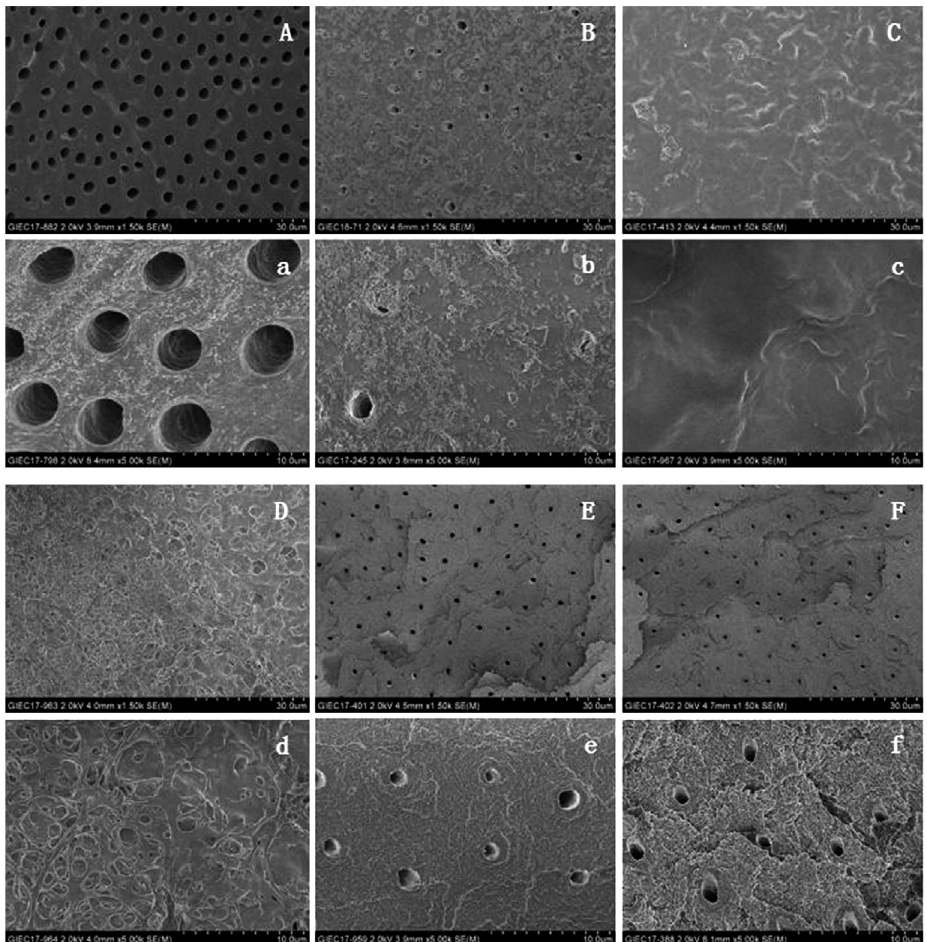
Figure 3- SEM Micrographs of treated dental specimens of group A (A,a; ×1500,×5000), group B (B,b; ×1500,×5000), group C (C,c; ×1500,×5000), group D (D,d; ×1500,×5000), group E (E,e; ×1500,×5000), group F (F,f;